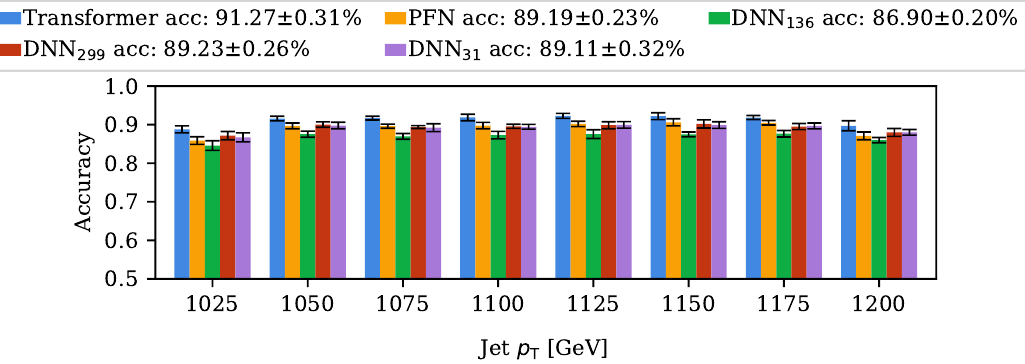
Figure 8 . Mean 10-fold accuracy and statistical uncertainty of the various networks predictions for jets in each class.